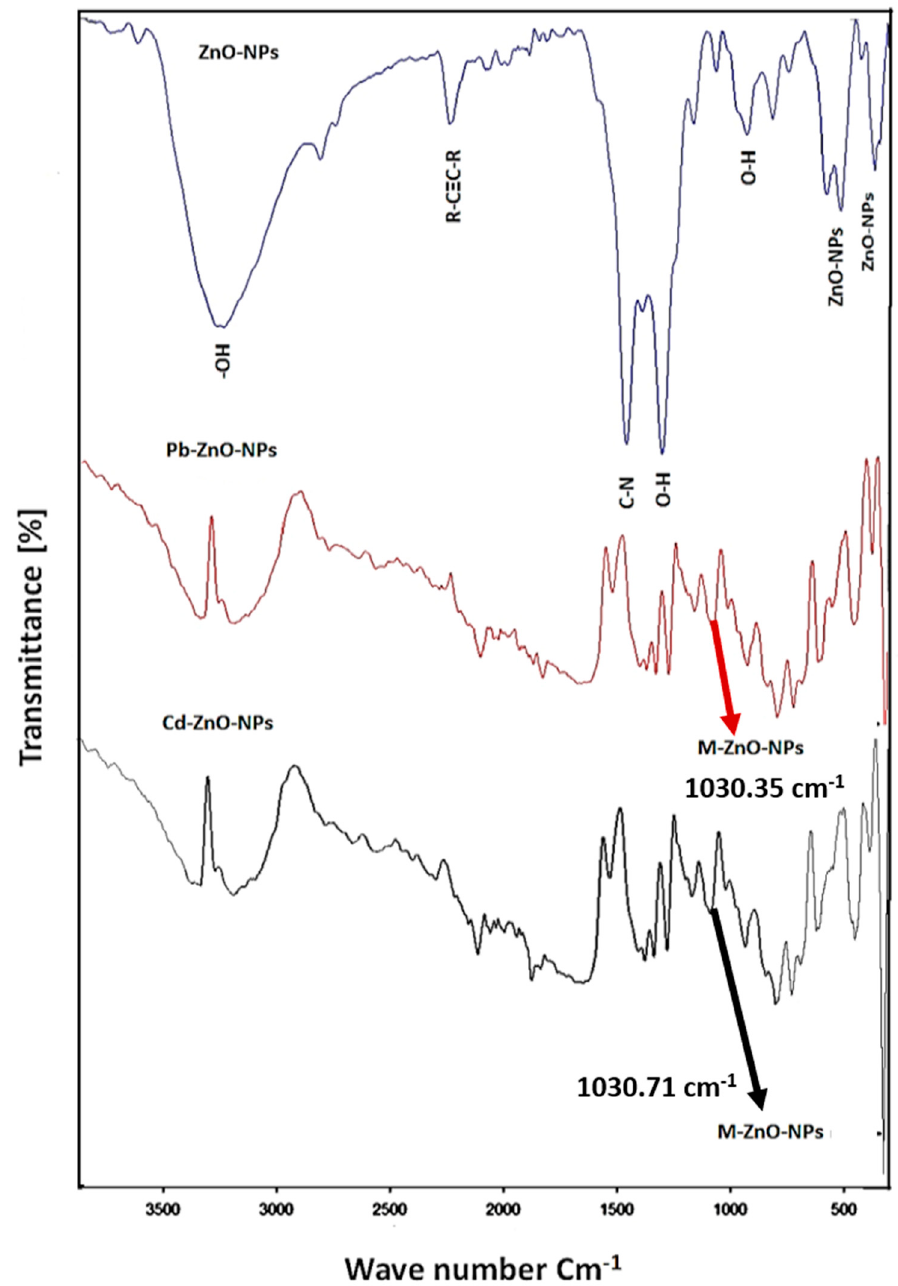
Figure 3. FT-IR spectrum of biosynthesized ZnO-NPs, ZnO-NPs-Pb, and ZnO-NPs-Cd using man- grove leaf extract.